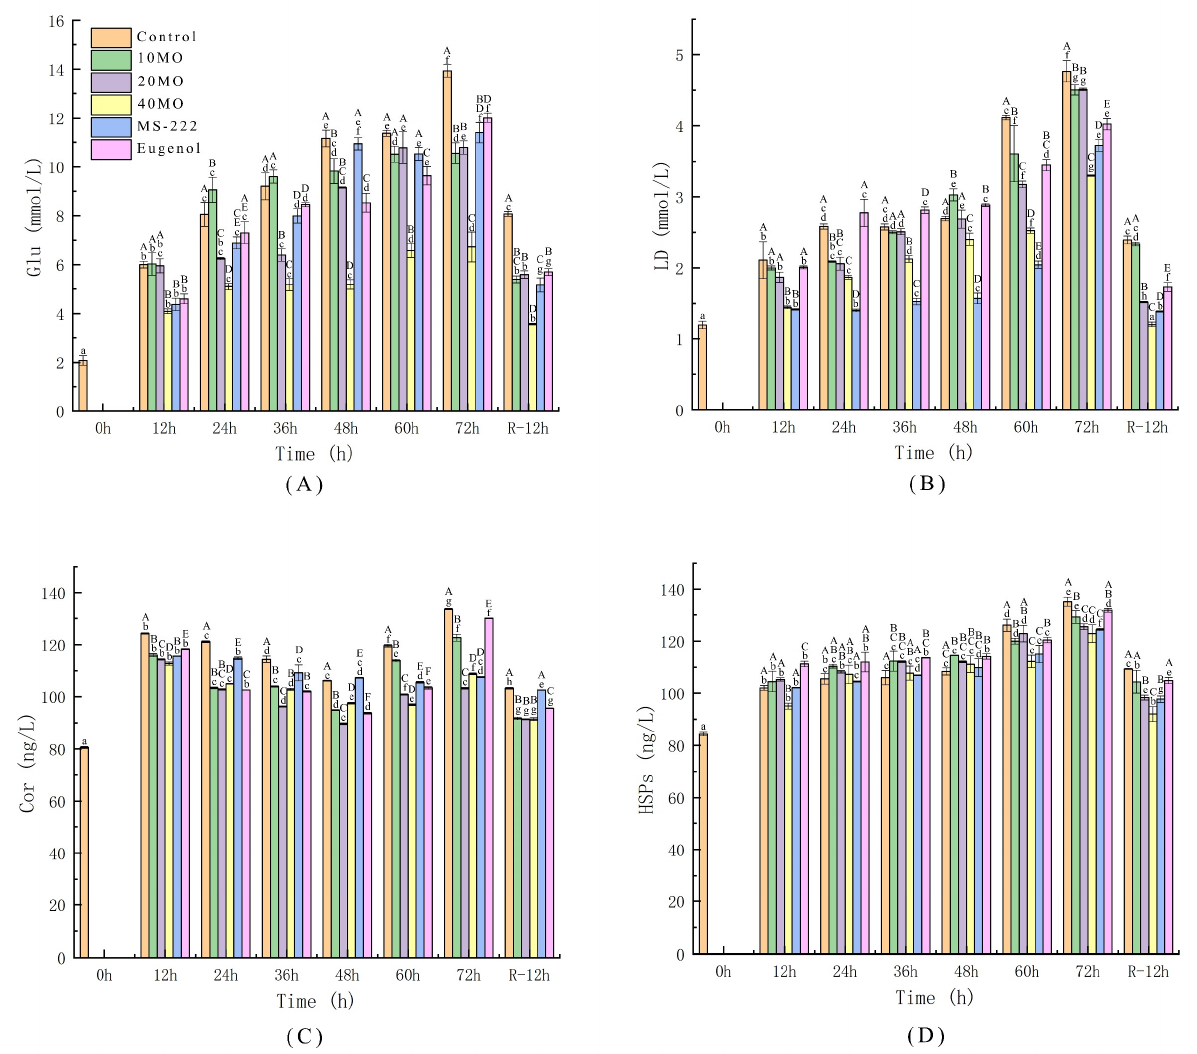
Figure 1. The changes in Glu ( A ), LD ( B ), Cor ( C ), and HSPs ( D ). 10 MO: 10 mg/L MOEO, 20 MO: 20 mg/L MOEO, 40 MO: 40 mg/L MOEO, MS-222: 30 mg/L MS-222, eugenol: 20 mg/L eugenol, control: no agent addition. Vertical bars indicate the standard deviation; Means with different lowercase letters indicate a significant difference between time intervals within each group ( p ≤ 0.01) while different capital letters indicate significant differences between groups in each time interval ( p ≤